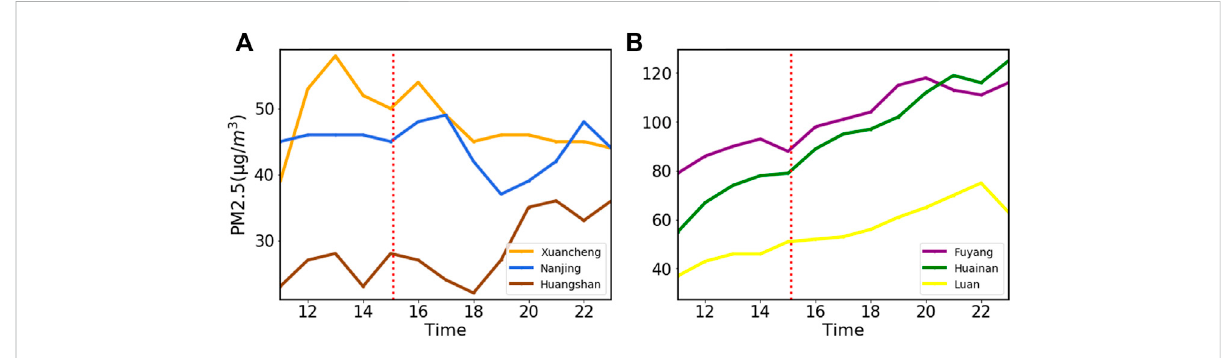
FIGURE 13 Time series of PM 2.5 in different cities in areas (A) with and (B) without arti fi cial seeding in fl uence. The red dotted line is seeding start